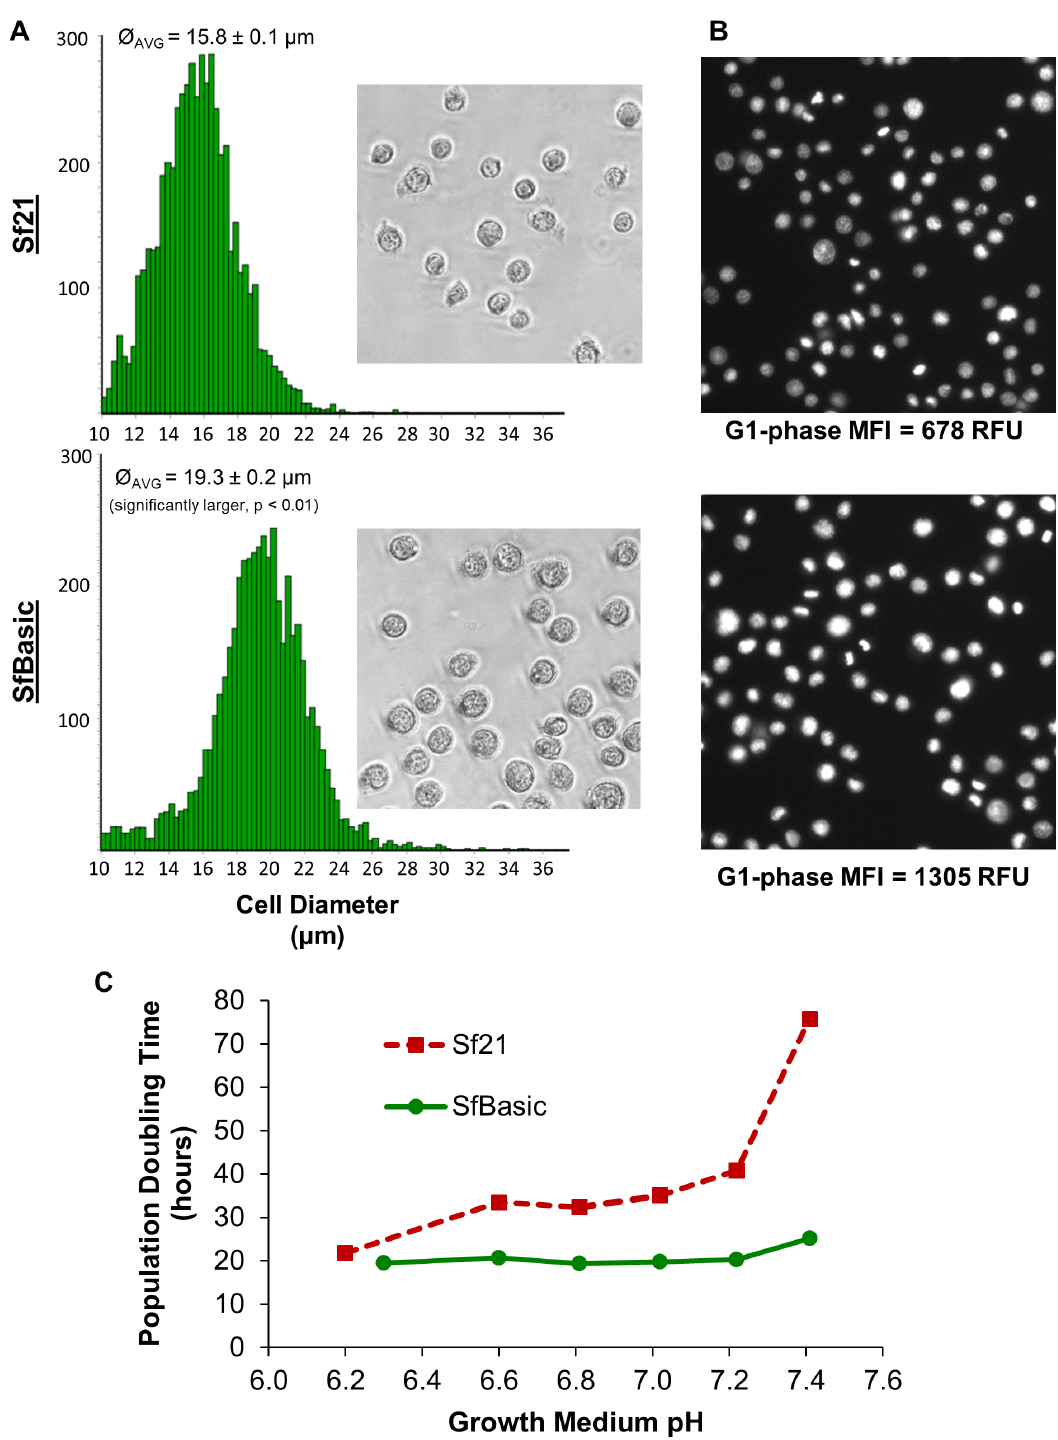
Figure 4. Characterization of the Sf Basic cell line and comparison to the parental Sf 21 cell line. ( A ) Cell diameter (Ø) distribution histogram with a representative bright field image. ( B ) Fluorescence microscopy images of propidium iodide stained cells. Mean fluorescence intensity (MFI) of the G1-phase cell population from flow cytometry cell cycle analysis of the same sample is indicated below the corresponding image. ( C ) Cell line population doubling time (PDT) as a function of growth medium pH. The growth medium was Sf-900II-BES-MISS, adjusted to various pH levels by titration with 1 N NaOH.